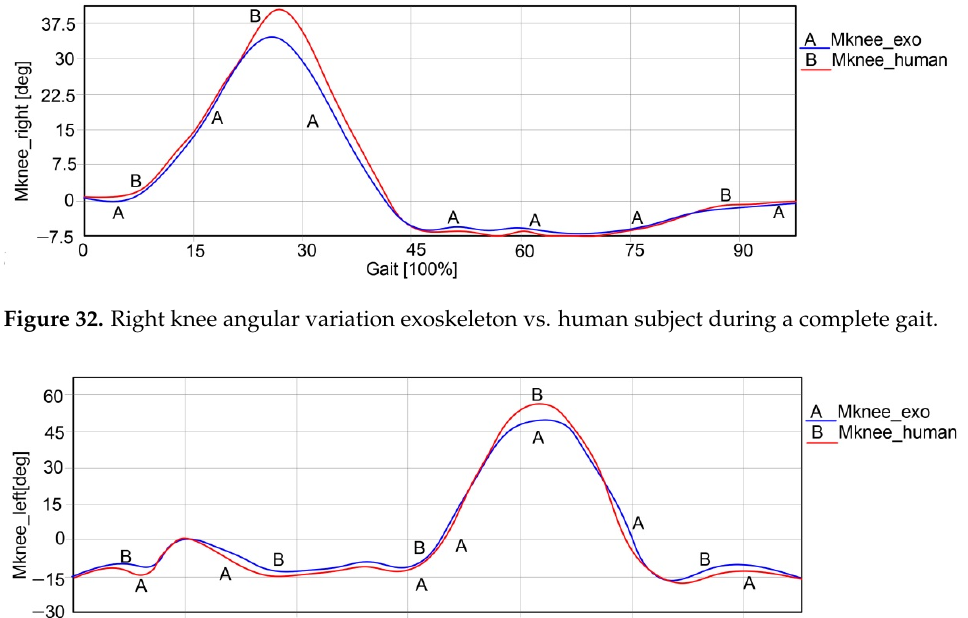
Figure 31. Right hip angular variation exoskeleton vs. human subject during a complete gait.